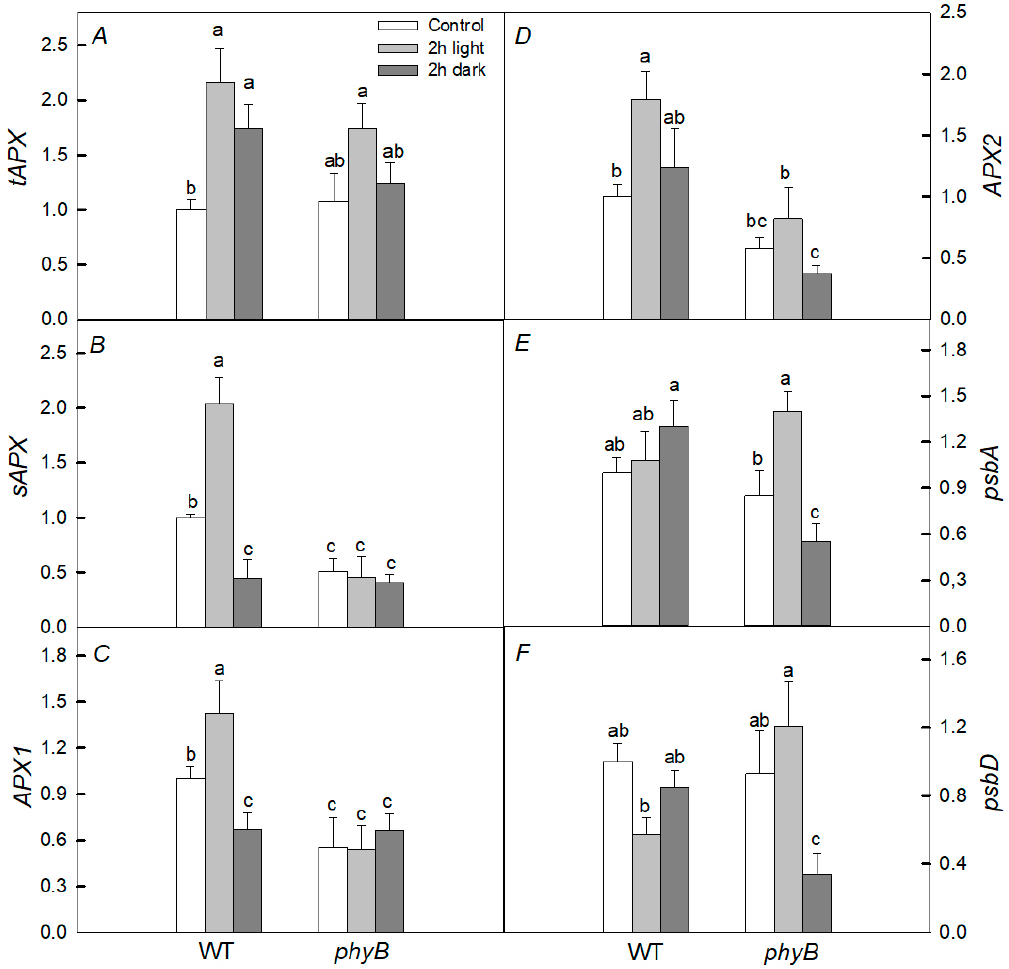
Figure 6. Effect of heat treatment (40 °C, 2 h) in the dark (dark) and in the light (light) on the expression of a number of tAPX ( A ), sAPX ( B ), APX1 ( C ), APX2 ( D ), psbA ( E ), and psbD ( F ) genes in WT plants and the phyB mutant. Mean values ± SD are shown ( n = 3). Different letters correspond to a significant difference in values at p < 0.05.